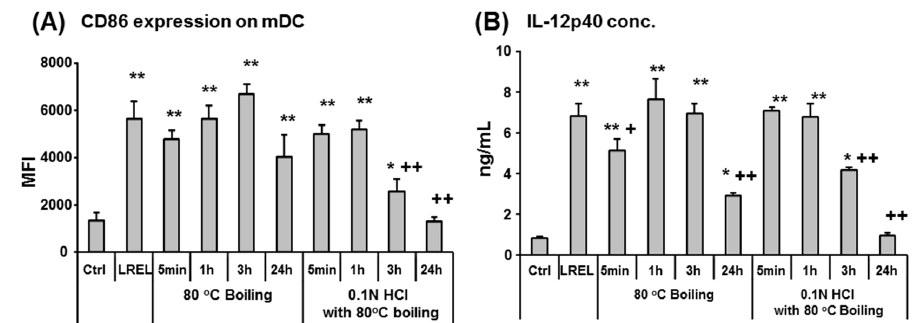
Figure 2. Effect of heat and acid treatment on LREL activity. LREL were boiled at 80 ◦ C with or without 0.1 N HCl for different time periods and then neutralized with 0.1 N NaOH to evaluate heat and